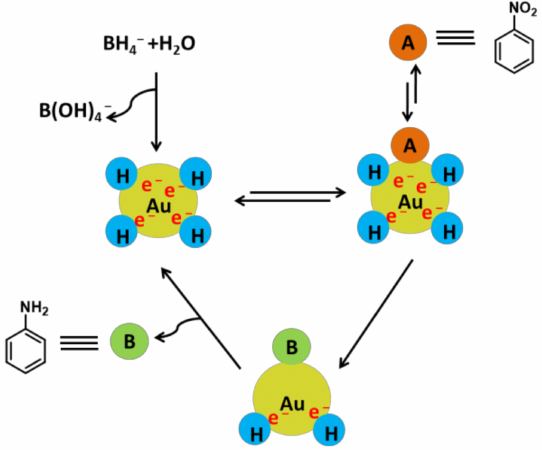
Figure 3. A possible mechanism diagram of the